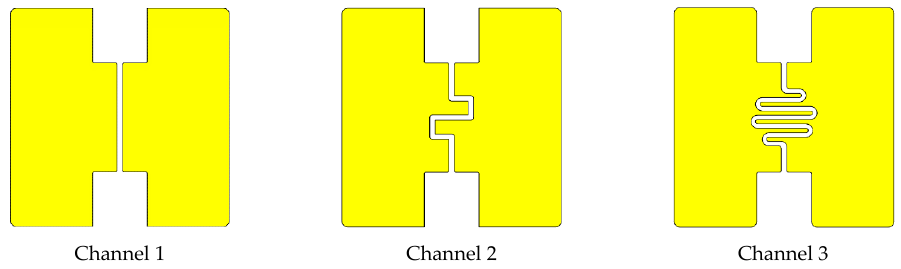
Figure 3. Microchannels for ionization chamber. Table 2. Ionization chamber properties.